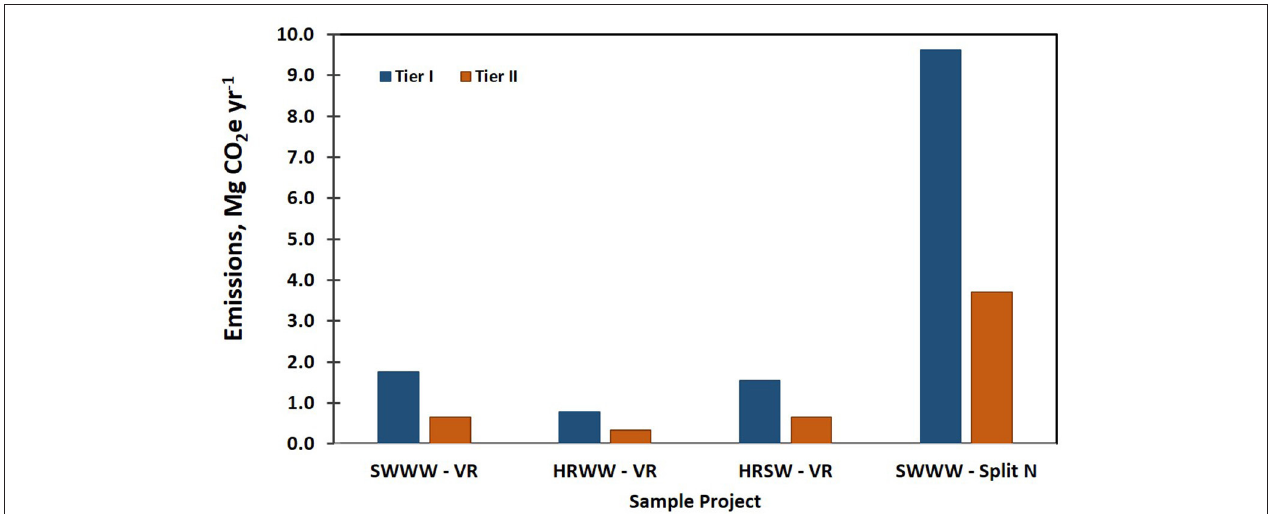
FIGURE 4 | Offset Credits for Project Activities under Tier I and Tier II Direct N 2 O Emission Factors. The IPCC Tier I default of 1% (blue) and potential Tier II emission factor of 0.2% (orange) of N fertilizer applied. The IPCC default indirect emission factors were used. Data represent field specific N application data from CAF-LTAR for sample projects. The American Carbon Registry Quantification Methodology was used to determine N 2 O emission reductions from management changes for: SWWW-VR, soft white winter wheat uniform to variable rate N (Sample Project 1); HRWW-VR, hard red winter wheat uniform to variable rate N (Sample Project 2); HRSW-VR, hard red spring wheat uniform to variable rate N (Sample Project 3); and SWWW-Split N from all fall to split N application between fall and spring (Sample Project 4).